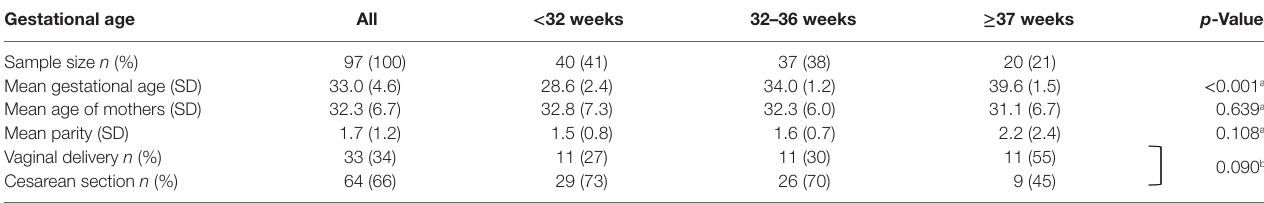
TaBle 1 | Birth-associated characteristics of the study group providing breast milk samples.